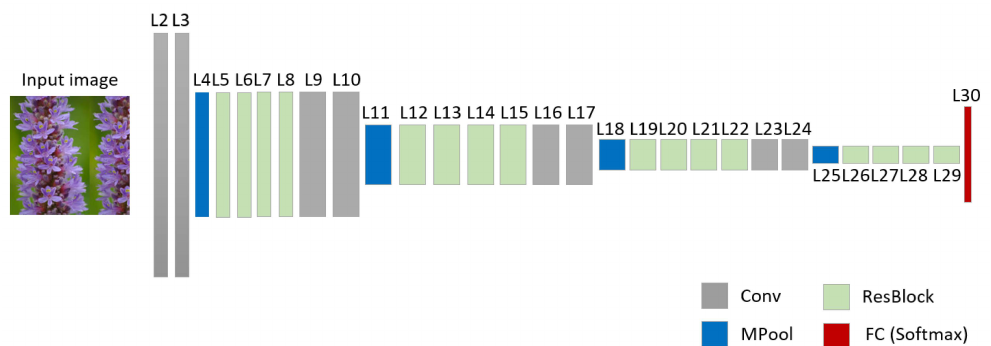
Figure 3. Example of the detailed structure of the proposed